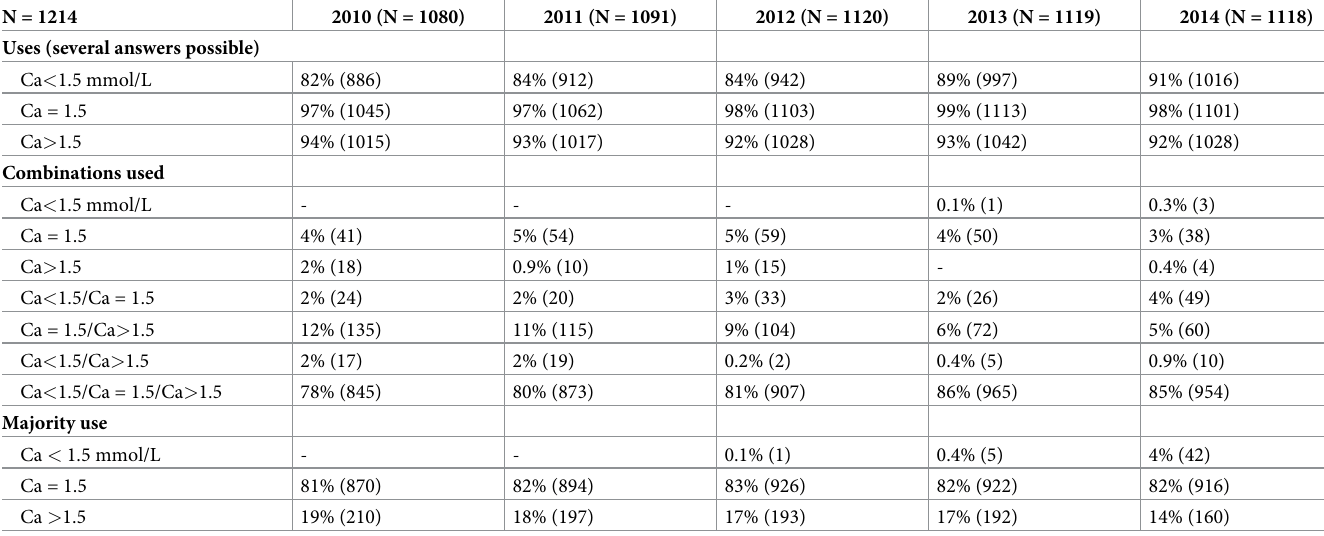
Table 1. Dialysate calcium concentrations by dialysis center in France from 2010 to